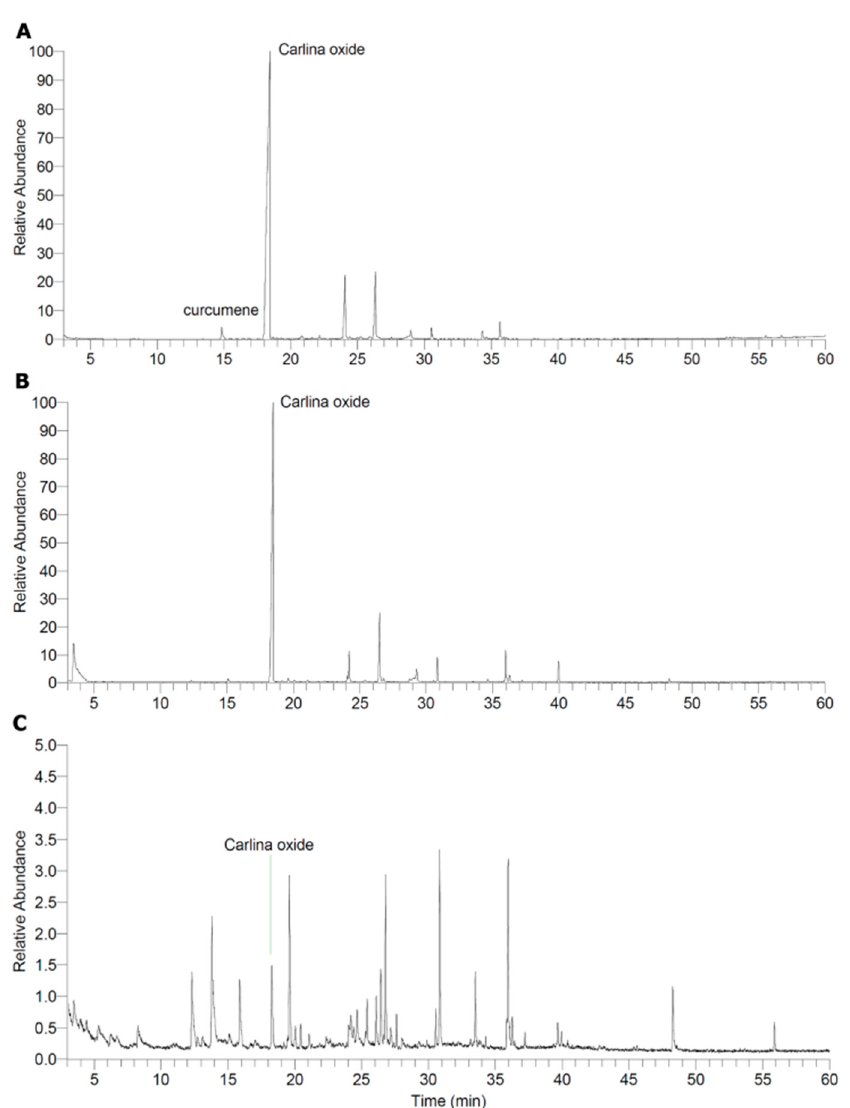
Figure 1. Total ion current of the GLC-MS measurements for the total dichloromethane extract of C. acaulis ( A ); fraction of the dichloromethane extract of C. acaulis containing mostly Carlina oxide (CarOx) ( B ); and the depleted extract ( C ).